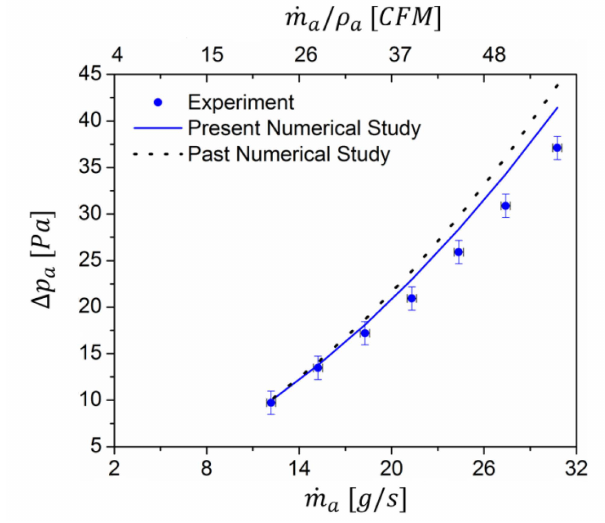
. for different m a . a